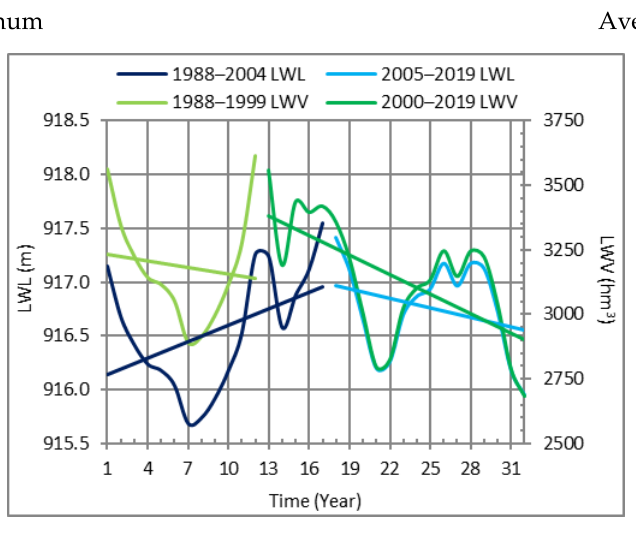
Table 3. Linear regression analysis equations for the different periods of the annual LWL and LWV series.